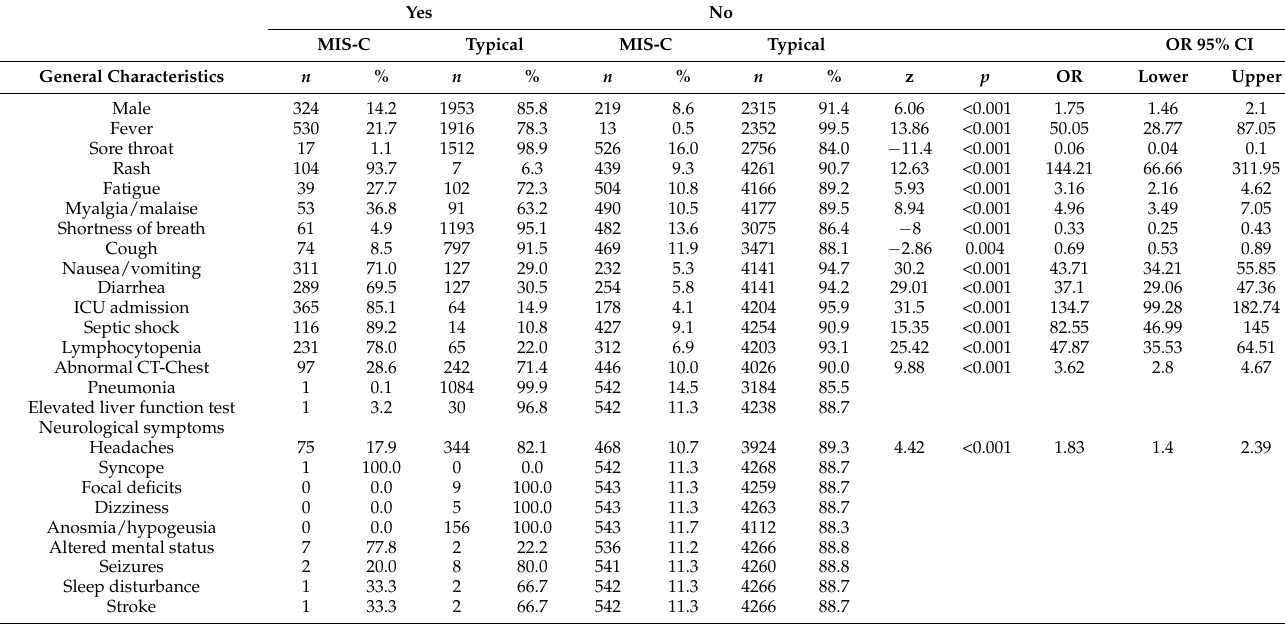
Table 2. Results from the logistic regressions, with odds ratios (OR) and confidence intervals (CI), for children with MIS-C and without MIS-C (typical)